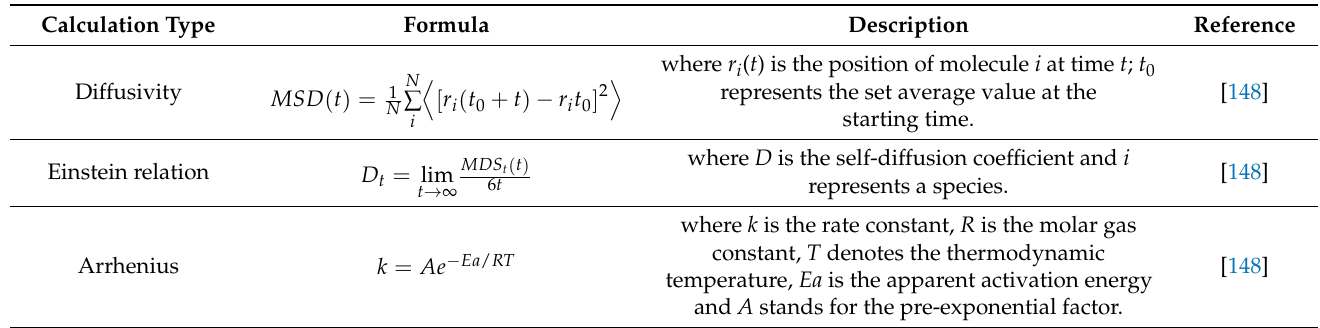
Table 3. Calculation for lithium-ion batteries’